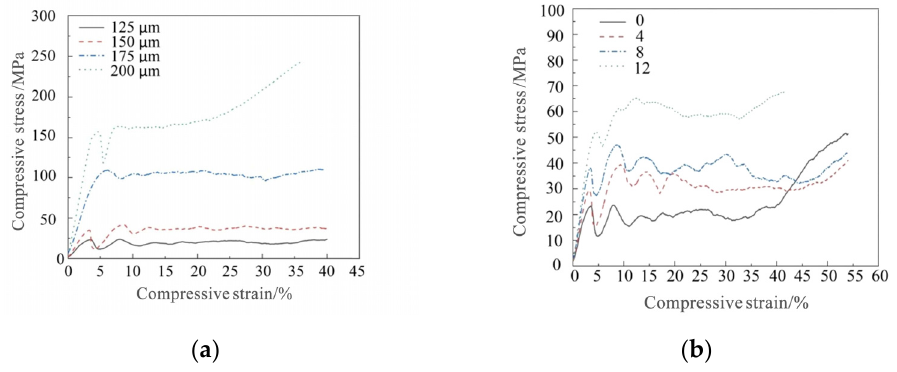
Figure 7. Compressive stress–strain curves: ( a ) zero internal struts and the strut diameters of 125– 200 μ m; ( b ) 0–12 internal struts and the strut diameter of 125 μ m.